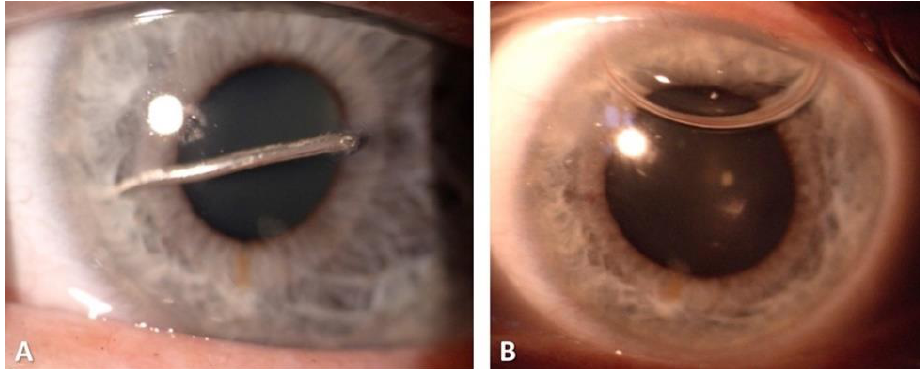
Figure 1. Zone I injury with corneal penetration by a nail. Before ( A ) and after surgery ( B ).